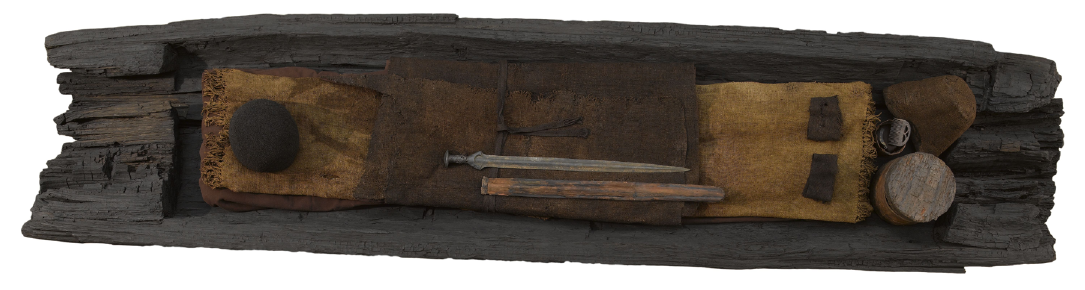
Figure 3. Oak coffin, male burial from Trindhøj (coffin A), southern Jutland. Early Bronze Age, Per. II. Photo: Roberto Fortuna and Kira Ursem, The National Museum of Denmark, licence CC